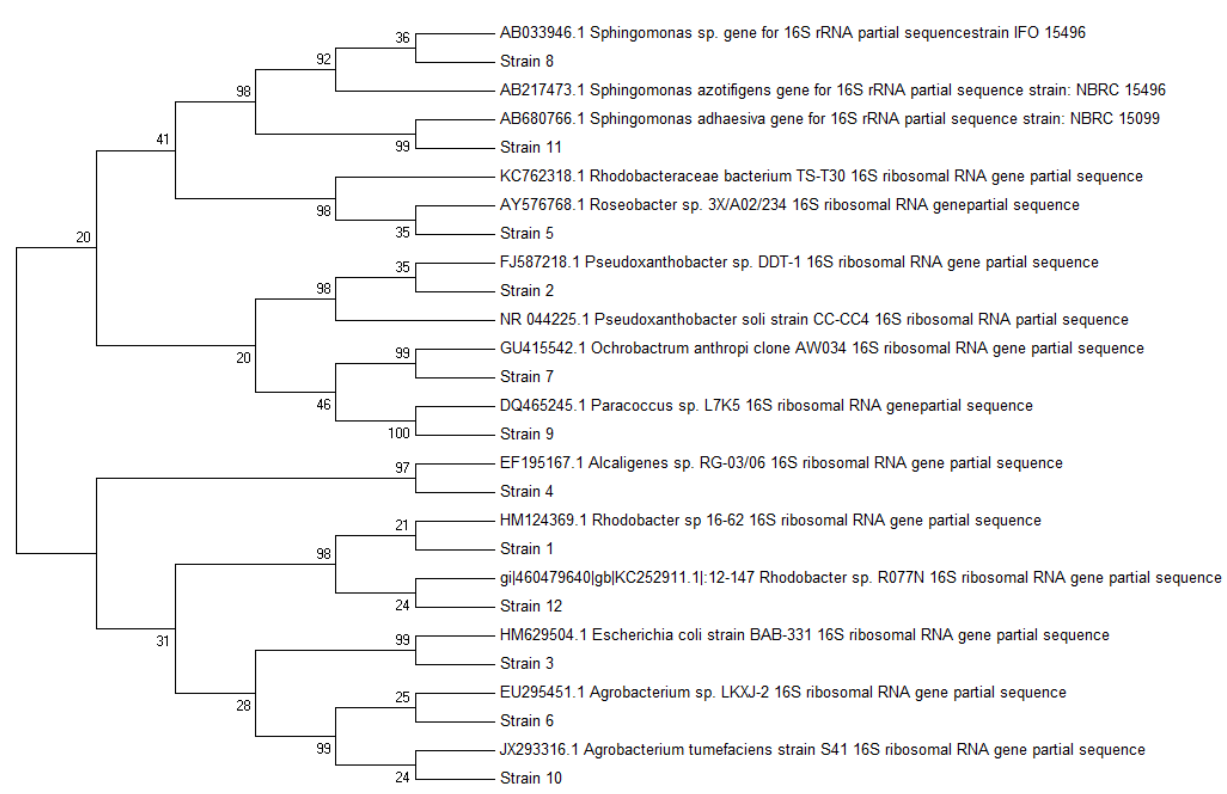
Figure 3. Neighbor-joining phylogenetic tree showing the position of 12 bacterial sequences and the most similar sequences retrieved from the EMB database, based on ca. 200 nt length of